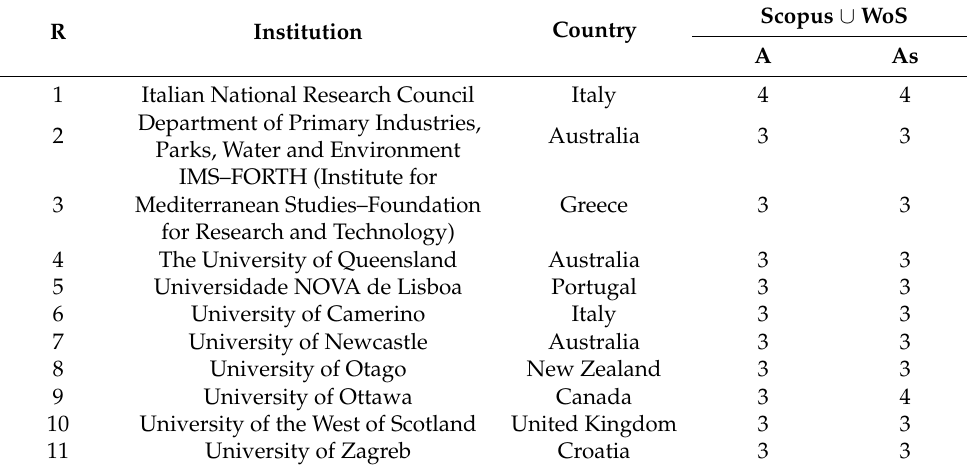
Table 5. Most productive institutions with authors and